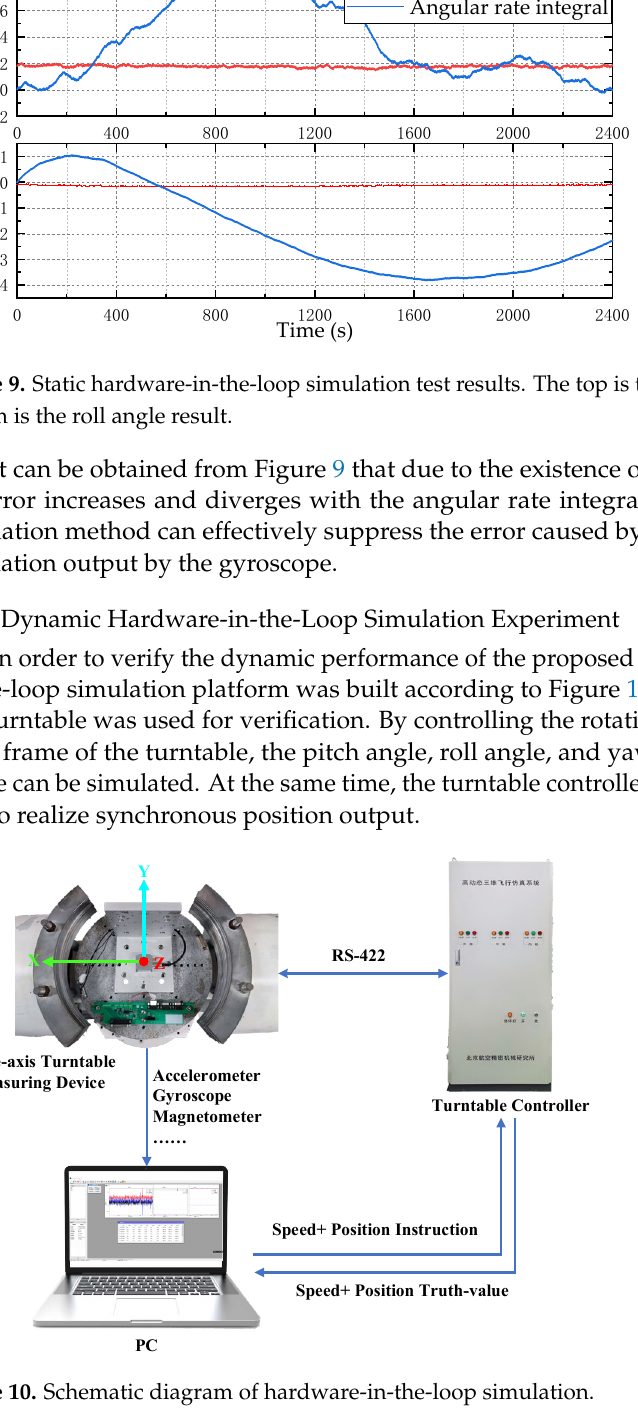
Figure 10. Schematic diagram of hardware-in-the-loop simulation.